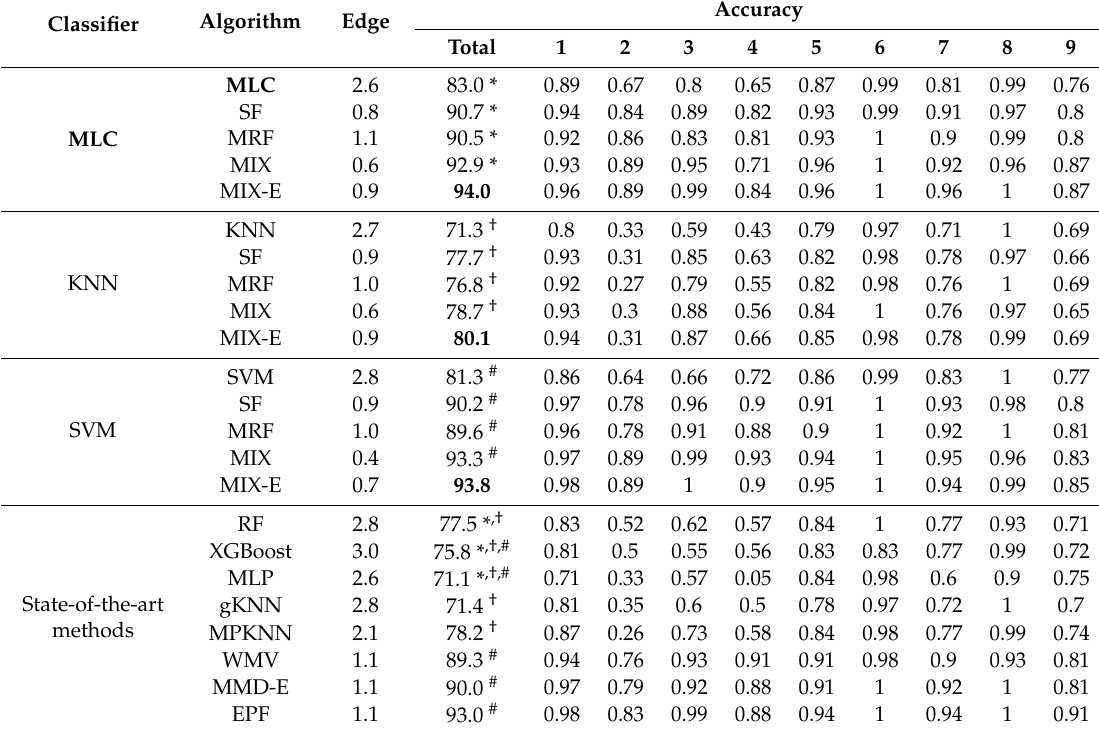
Table 2. Overall accuracy (%), F1-score per class, and edge index of classification results for the ROSIS